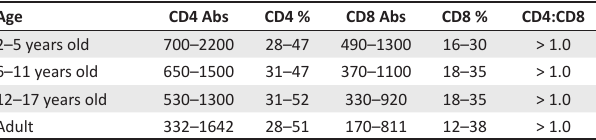
TABLE 4b: Laboratory reference ranges.